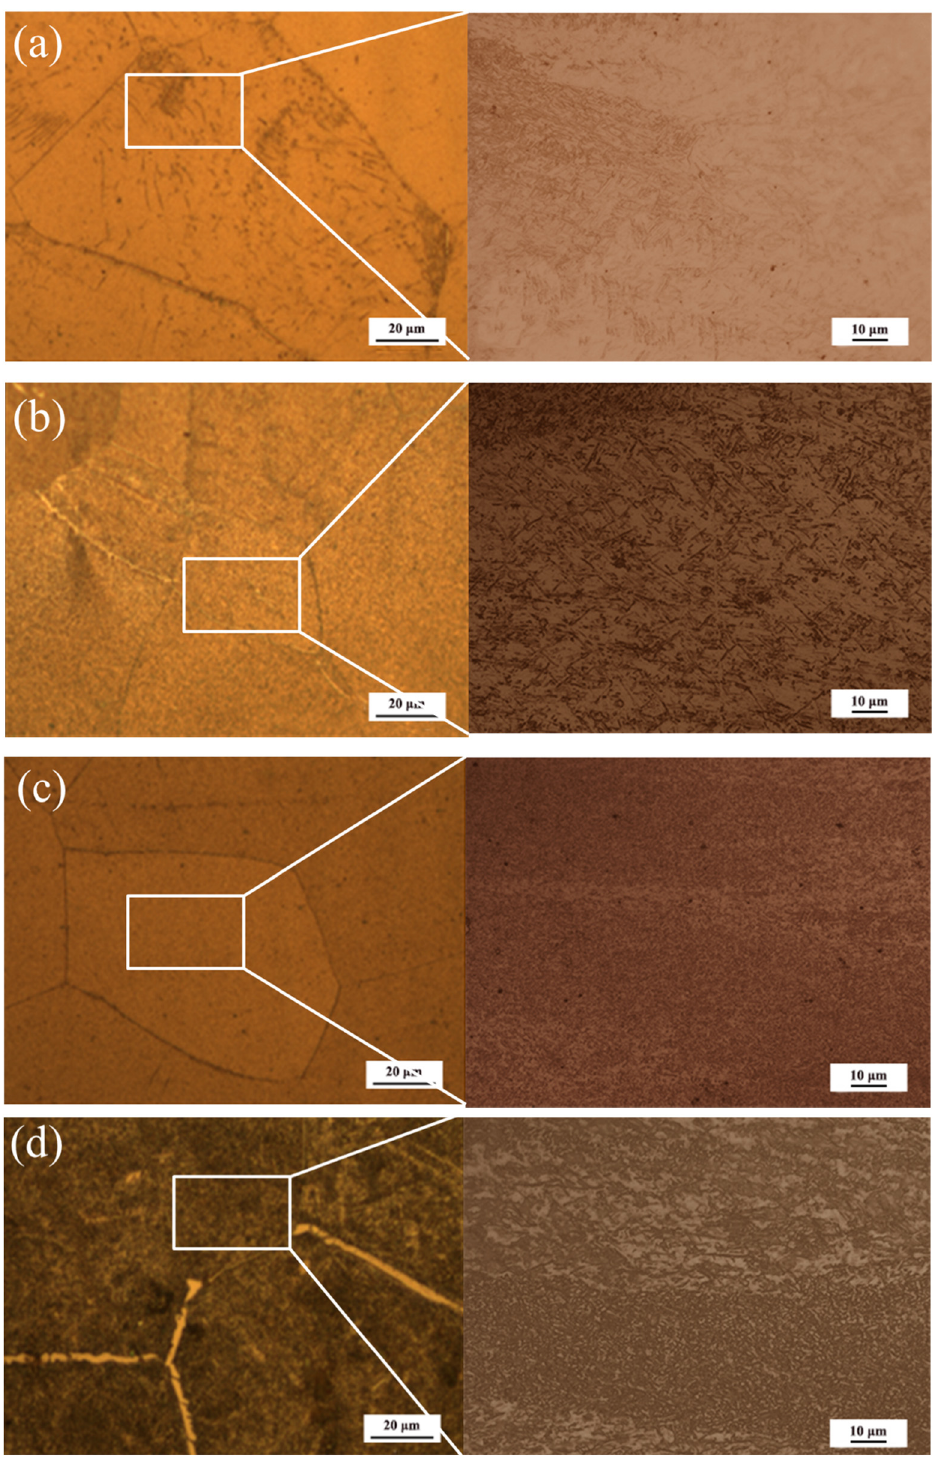
Figure 6: Microstructures of sample solutions aging - treated at the solution temperature of 820°C and aging temperatures of ( a ) 480°C, ( b ) 510°C, ( c ) 540°C and ( d ) Figure 6 revealed the results of solution - aging treatment at the solution temperature of 820°C and aging tem - peratures of 480°C, 510°C, 540°C and 570°C. Apparently,